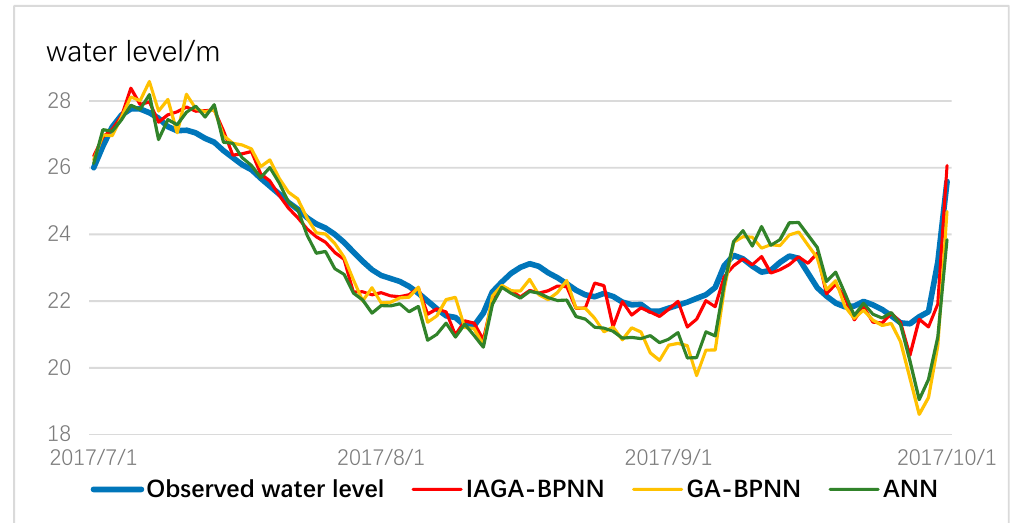
Figure 10. Comparison results for the three models for water-level prediction from July to September 2017.